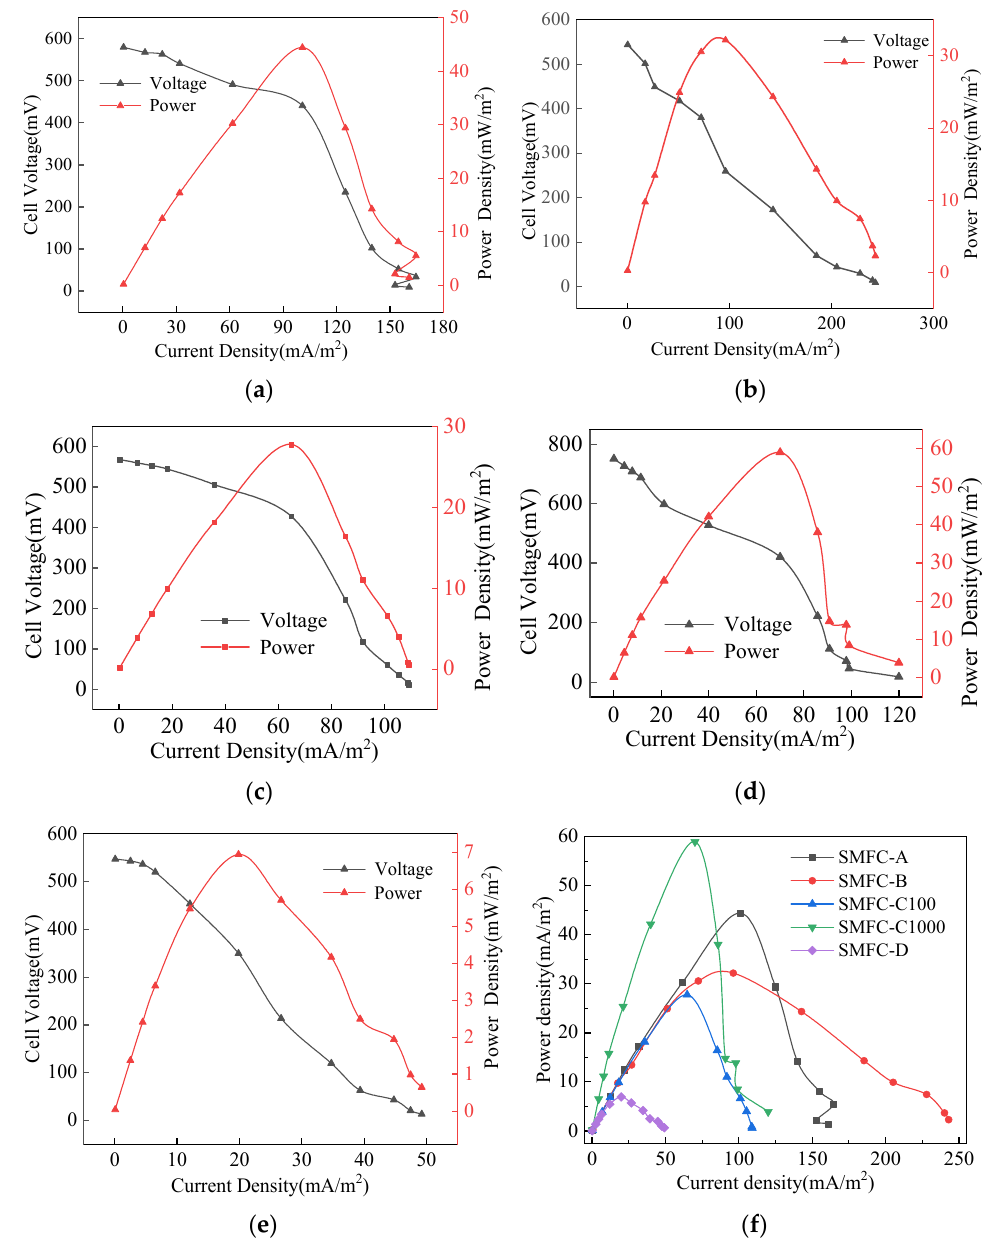
Figure 3. Polarization and power density of SMFCs. ( a ) Polarization curve of SMFC-A; ( b ) Polariza- tion curve of SMFC-B; ( c ) Polarization curve of SMFC-C100; ( d ) Polarization curve of SMFC-C1000; ( e ) Polarization curve of SMFC-D; ( f ) Power density curves of SMFC.